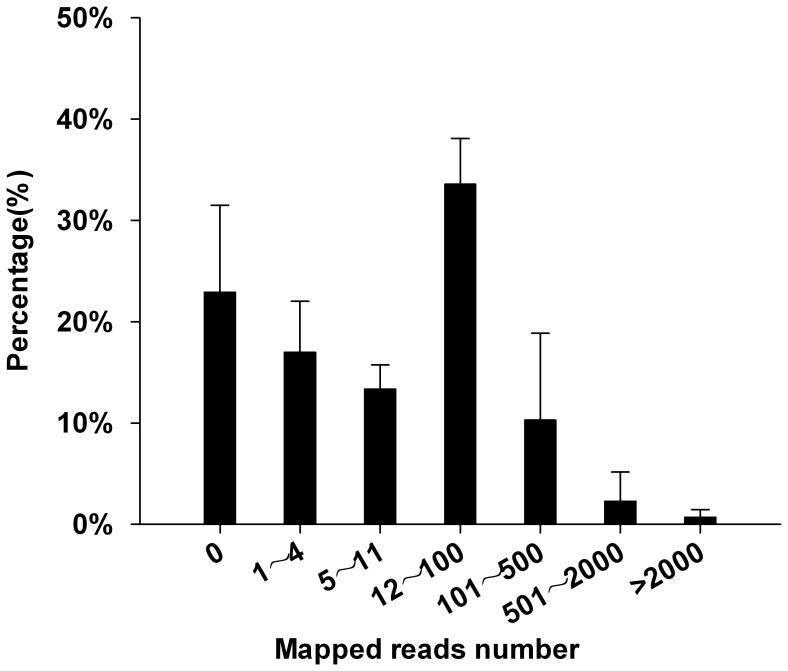
Distribution of HQ reads mapped to TriallCDNA.HQ reads from the four libraries were aligned to the TriallCDNA reference set. Shown is the percentage of mapped reads (y axis) vs. copies (x axis).